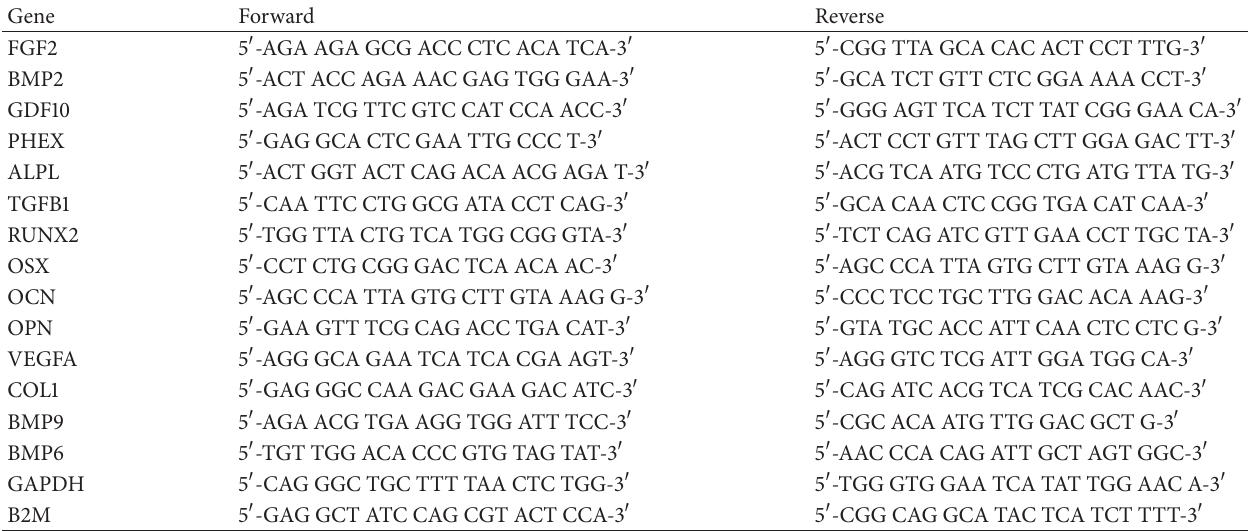
Table 1: List of primers used in this study for qRT